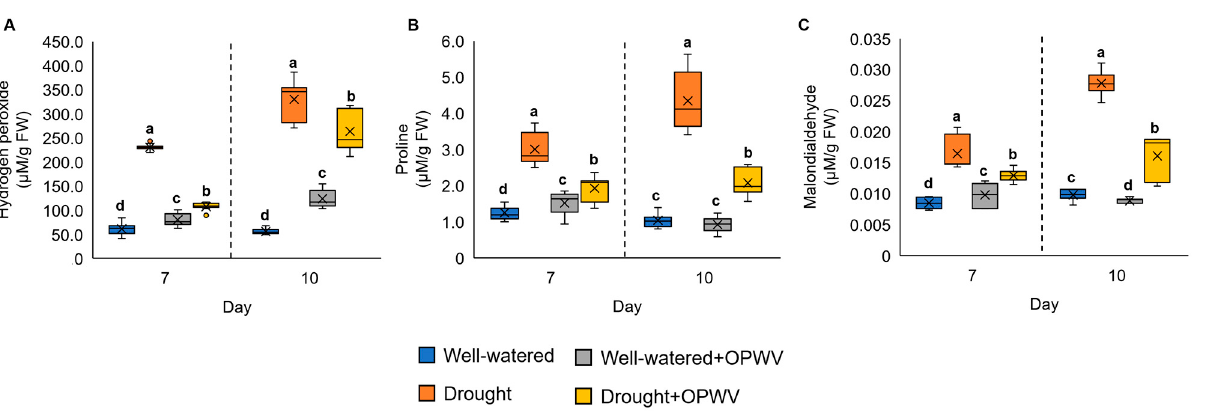
Figure 7. The antioxidant enzyme activities of the well-watered and drought-stressed Pandanus am- aryllifolius plants with or without OPWV for 7 and 10 days. ( A ) Superoxide dismutase (SOD). ( B )